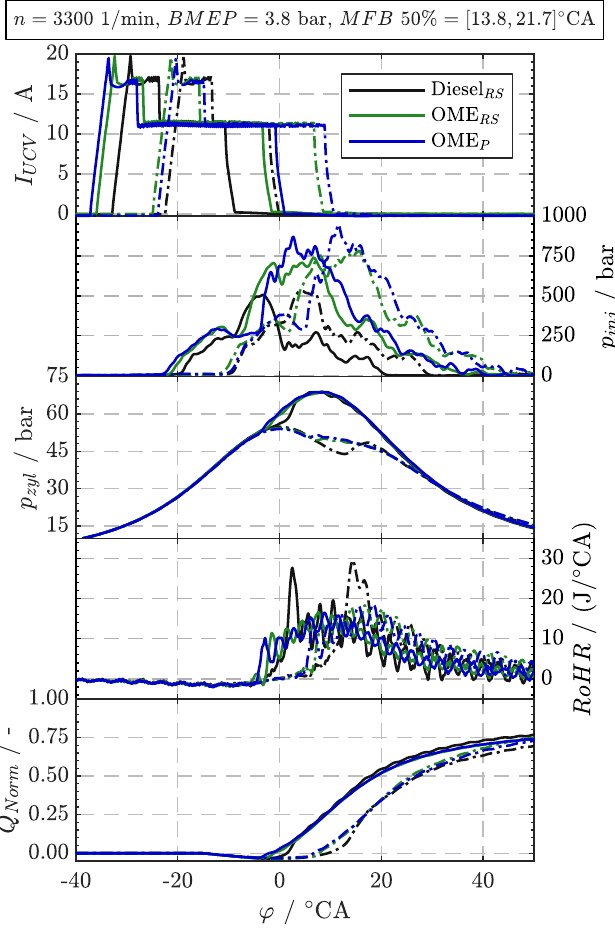
Figure 6. Drive current of high − pressure pump solenoid valve, pressure in injection line, cylinder pressure, rate of heat release and normalized released heat as a function of crank angle at two different MFB 50% timings for OP 2 and for two different nozzles in OME − operation. Solid lines